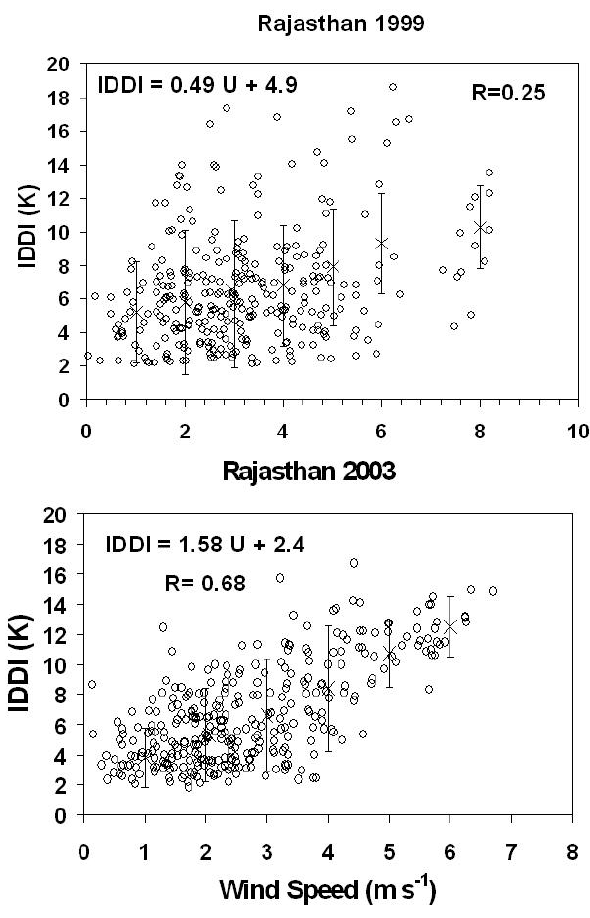
40Fig. 9. Scatter plot of daily IDDI versus wind speed for Rajasthan. The Points with vertical Fig. 9. Scatter plot of daily IDDI versus wind speed for Rajasthan. bar represent bin average and vertical bar represent standard deviation. The solid line represents linear least-squares fit to the data